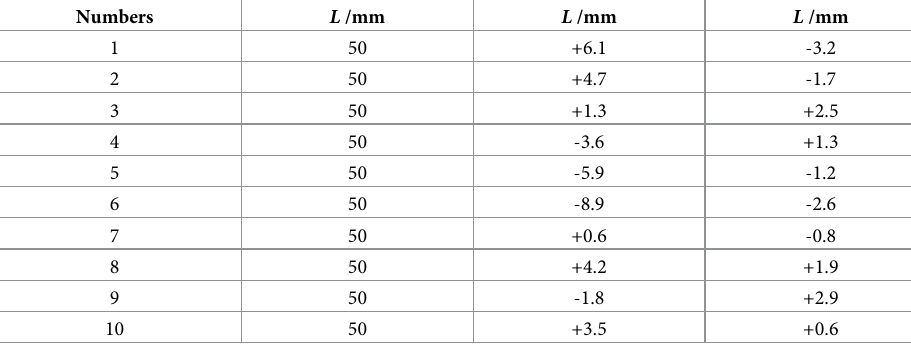
Table 6. Comparison table of unwinding and deviation correction